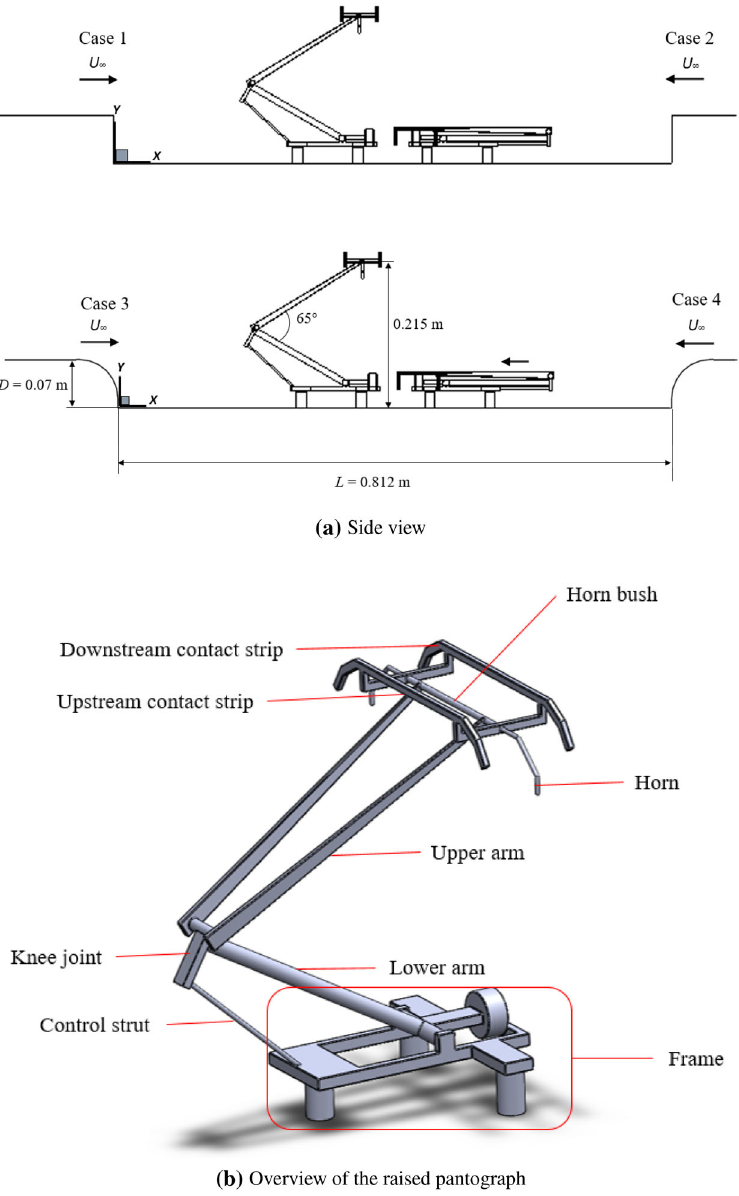
Fig. 11 Description of the geometry